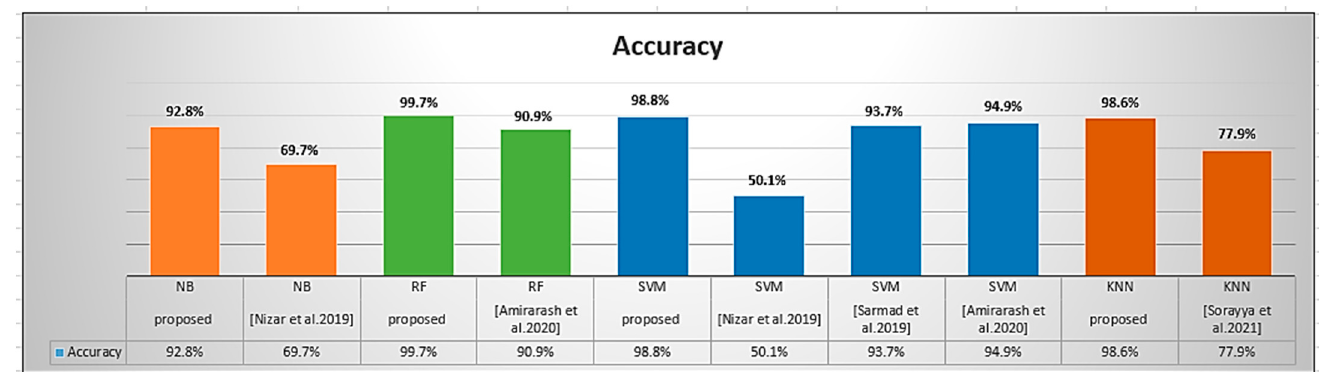
Figure 17. A graph showing classifiers’ accuracy obtained from the proposed work and the similar classifiers used in other references [1,2,4,10].